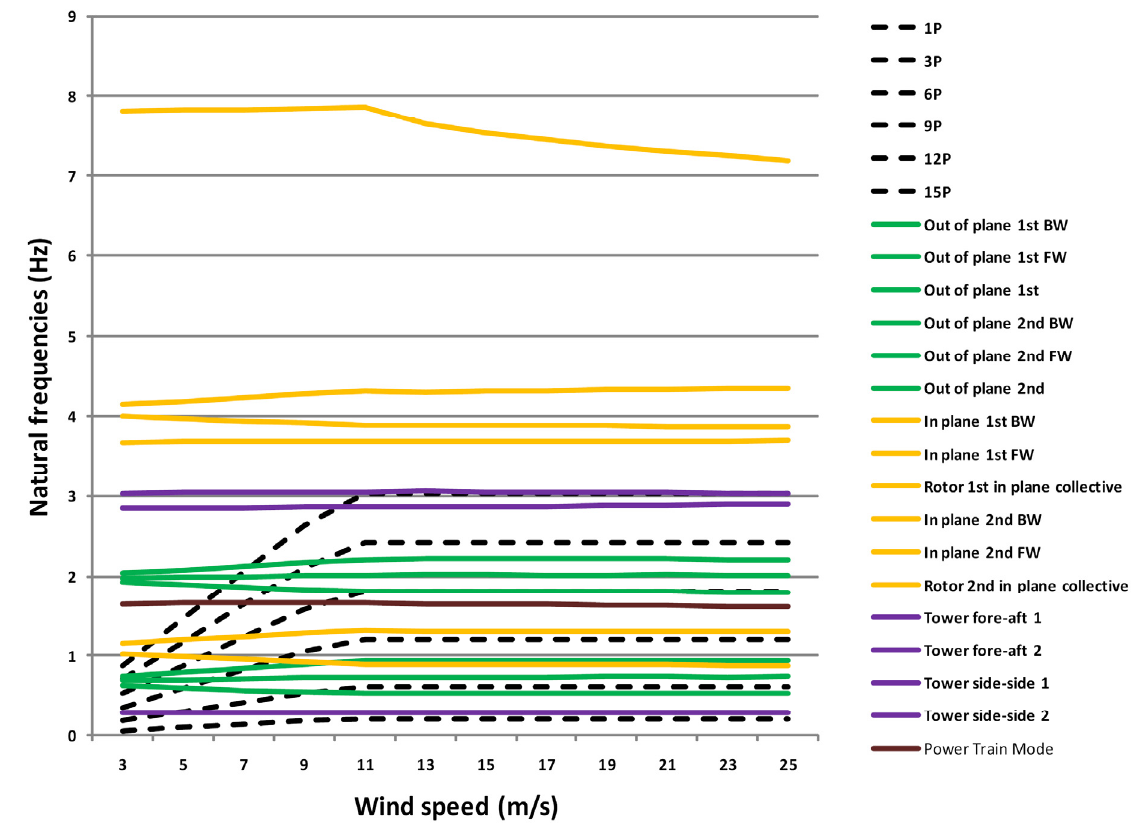
Figure 1. Campbell diagram for the Upwind